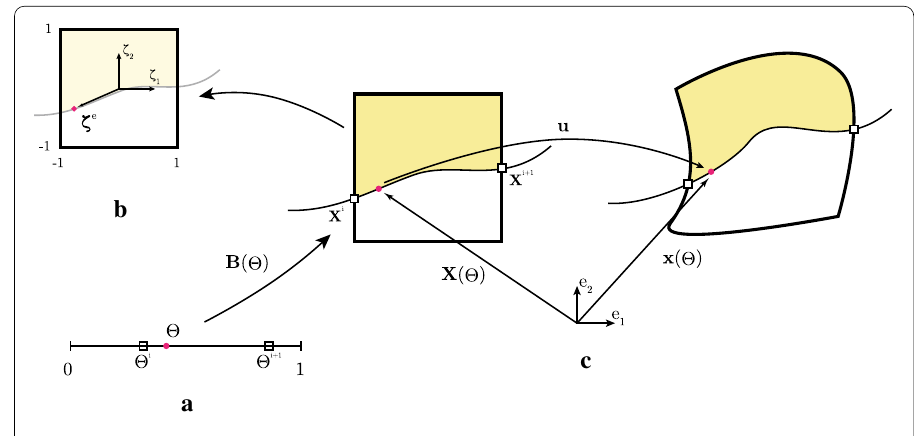
Fig. 4 Convective to local coordinates transformation. A point located at (cid:3) in the surface parametric space ( a ) is mapped to the reference configuration X ( (cid:3) ) on the global coordinates system ( c ) and then to the local element space ( b ) with coordinates ζ